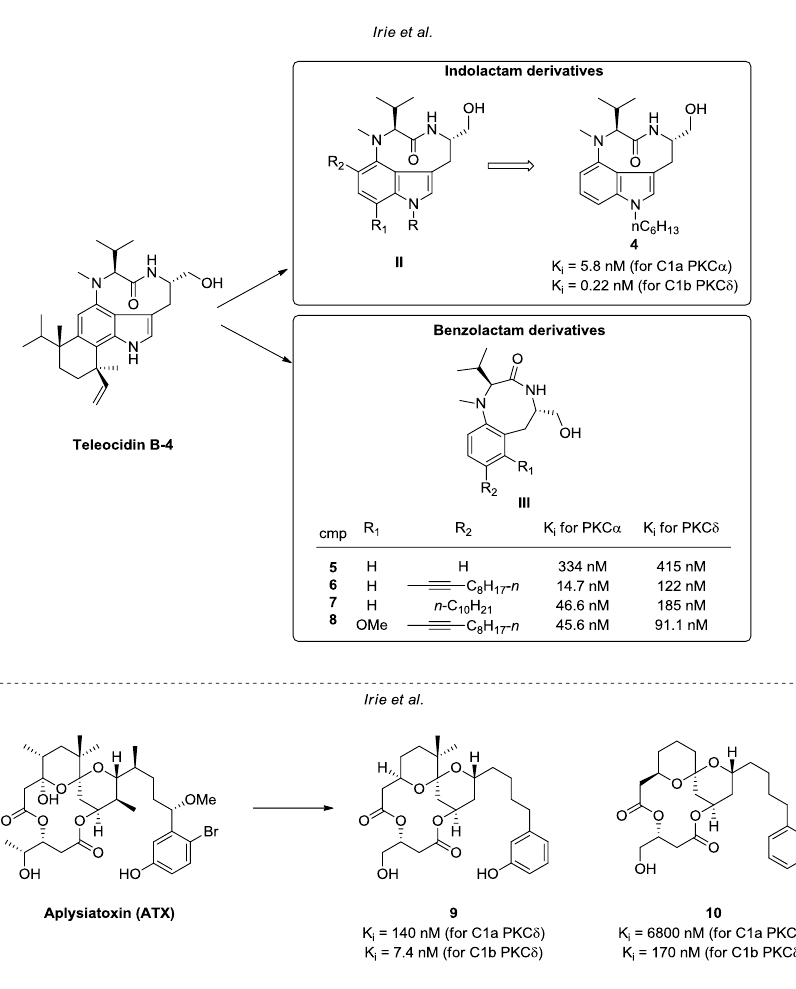
Figure 8. Teleocidin B-4 and ATX derivatives.